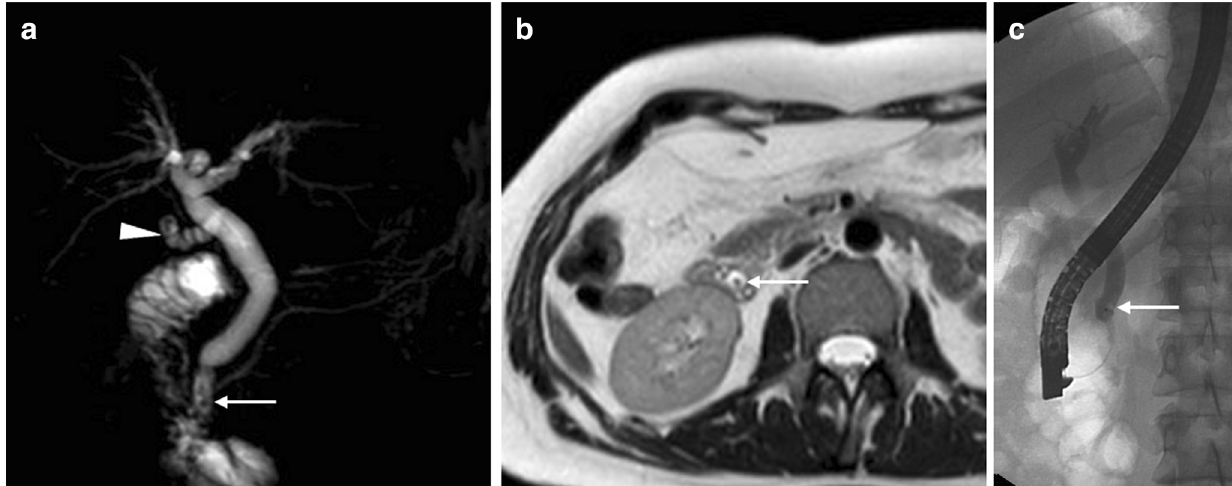
Fig. 15 Residual lithiasis in the common bile duct (CBD) following recent (10 days) laparoscopic cholecystectomy performed at another hos- pital. MRCP ( a ) and axial T2-weighted ( b ) MR images showed unre- markable cystic duct remnant ( arrowhead ) and mildly dilated CBD with